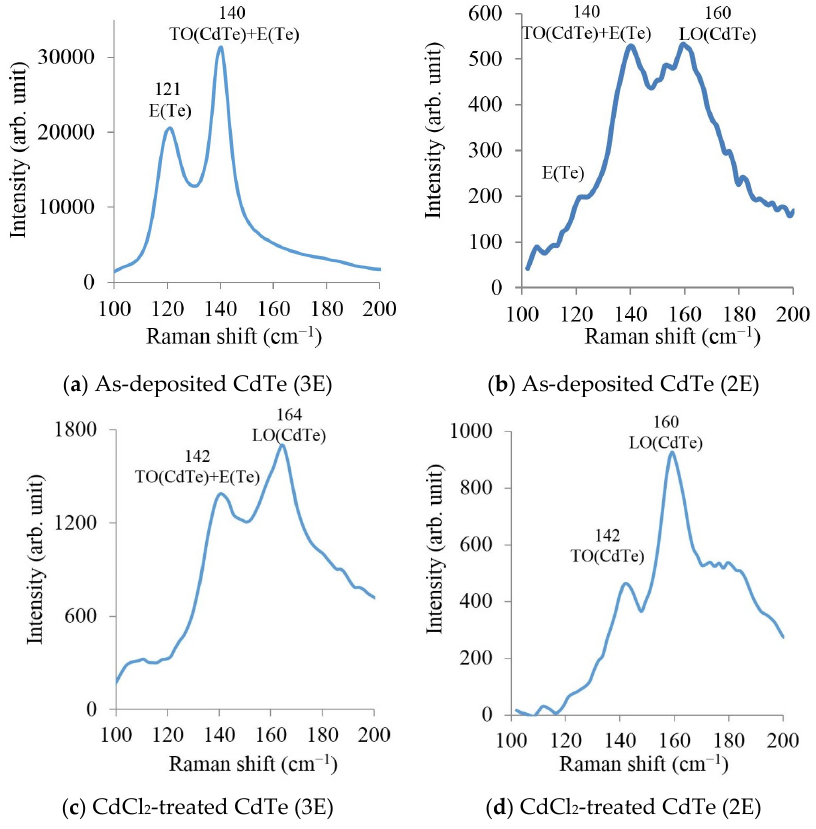
Figure 6. Plot of the Raman spectra of CdTe thin films for as ‐ deposited and CdCl 2 ‐ treated layers. The samples were grown using ( a , c ) 3E and ( b , d ) 2E, respectively. The surfaces were thoroughly washed with deionized water after CdCl 2 treatment.